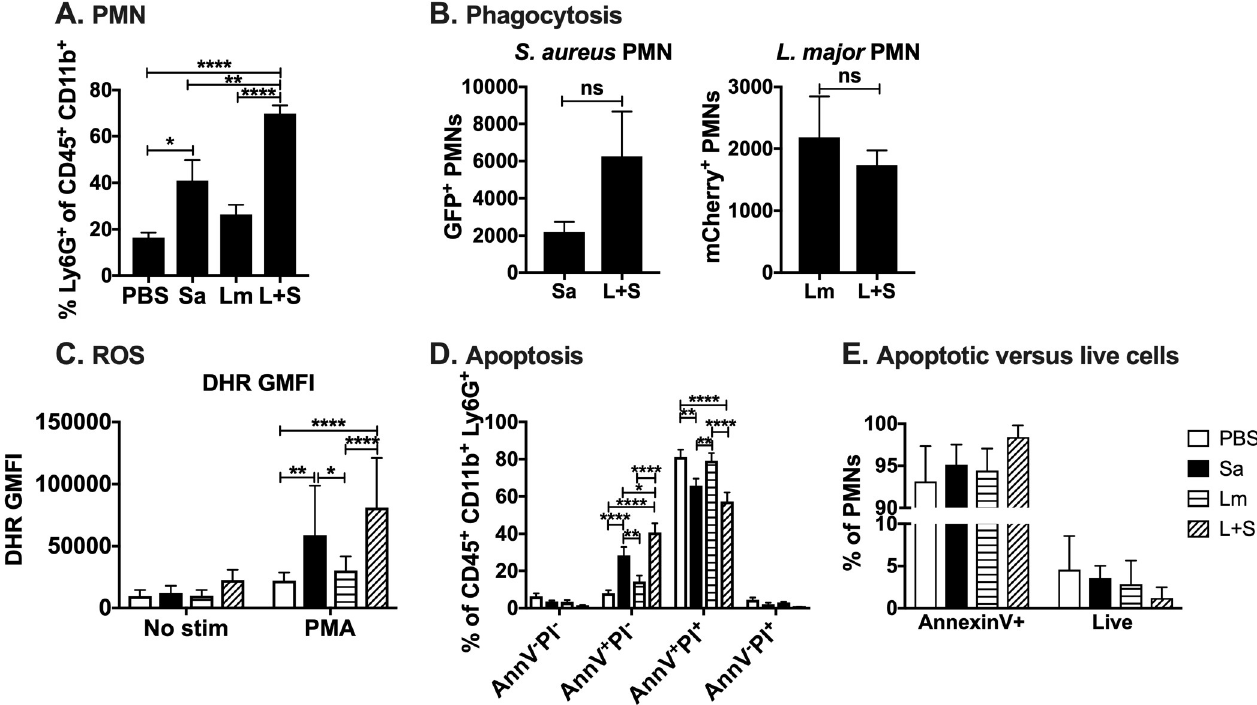
Fig 3. Neutrophils in L . major-S . aureus coinfected lesions can phagocytose pathogens and have functional NADPH oxidase but are mostly apoptotic. (A) Percentage of myeloid cells that are neutrophils from mice injected intradermally in the ear with phosphate buffered saline (PBS), L . major IA-2 (Lm), S . aureus Newman (Sa), or coinfected with L . major and S . aureus (L+S) for one day. (B) Numbers of polymorphonuclear cells (PMNs) positive for S . aureus LAC GFP or L . major IA-2 luc mCherry in singly infected versus coinfected lesions. (C) Dihydrorhodamine (DHR) geometric mean fluorescence intensity (GMFI) of neutrophils stimulated with PMA ex vivo in the presence of DHR to assess NADPH oxidase activity. (D) Annexin V (AnnV) and propidium iodide (PI) staining of neutrophils from PBS, S . aureus , L . major , or coinfected lesions. (E) Percentage of apoptotic (Annexin V + ) versus live (AnnV - PI - ) neutrophils from day 1 p.i. PBS, S . aureus , L . major , or coinfected ears. Data are represented as the mean ± SEM of two replicate experiments each with 5 mice/group. � p < 0.05, �� p < 0.01, ��� p < 0.001, ���� p < 0.0001, ns = not significant by Student’s t test (B), or one-way (A, C) or two-way ANOVA (D) with Tukey’s